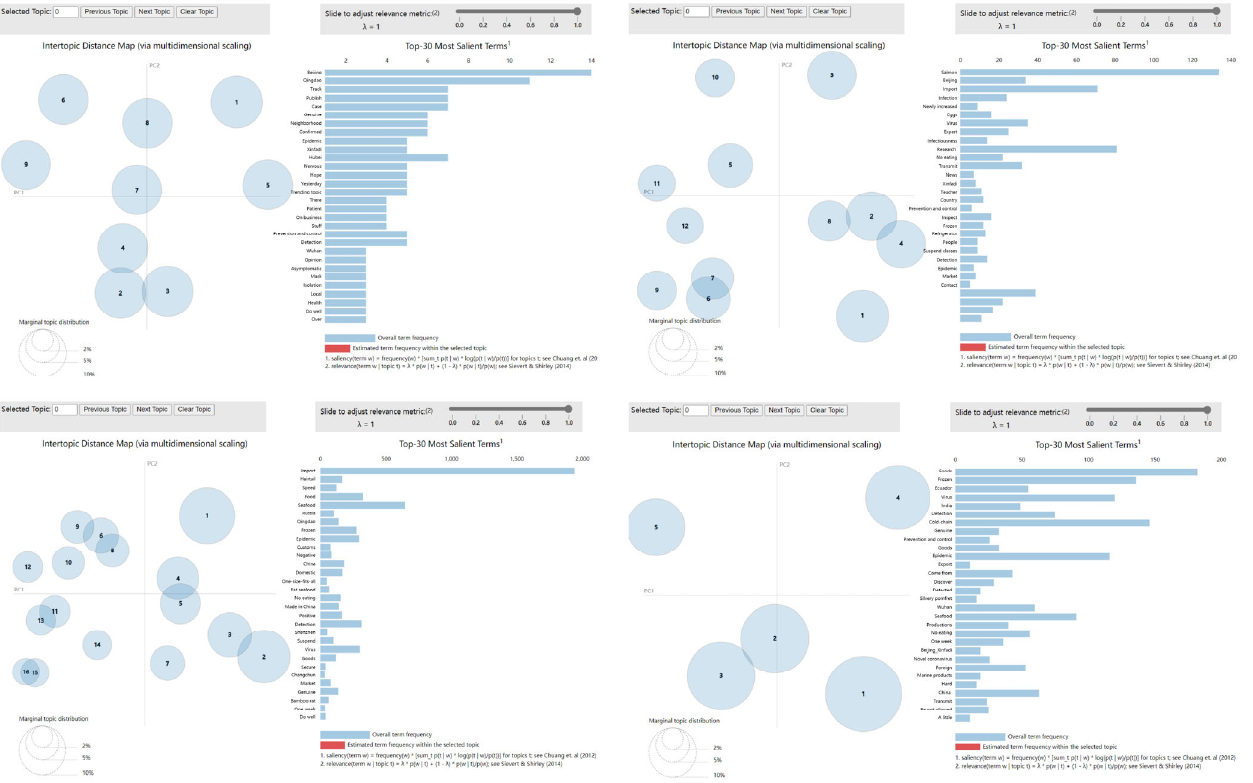
Figure 2. Visualization results of the topic clustering of netizen comments at each stage of public opinion. Table 2. Topic words and a summary of the content that netizens focus on at each stage of public opinion.